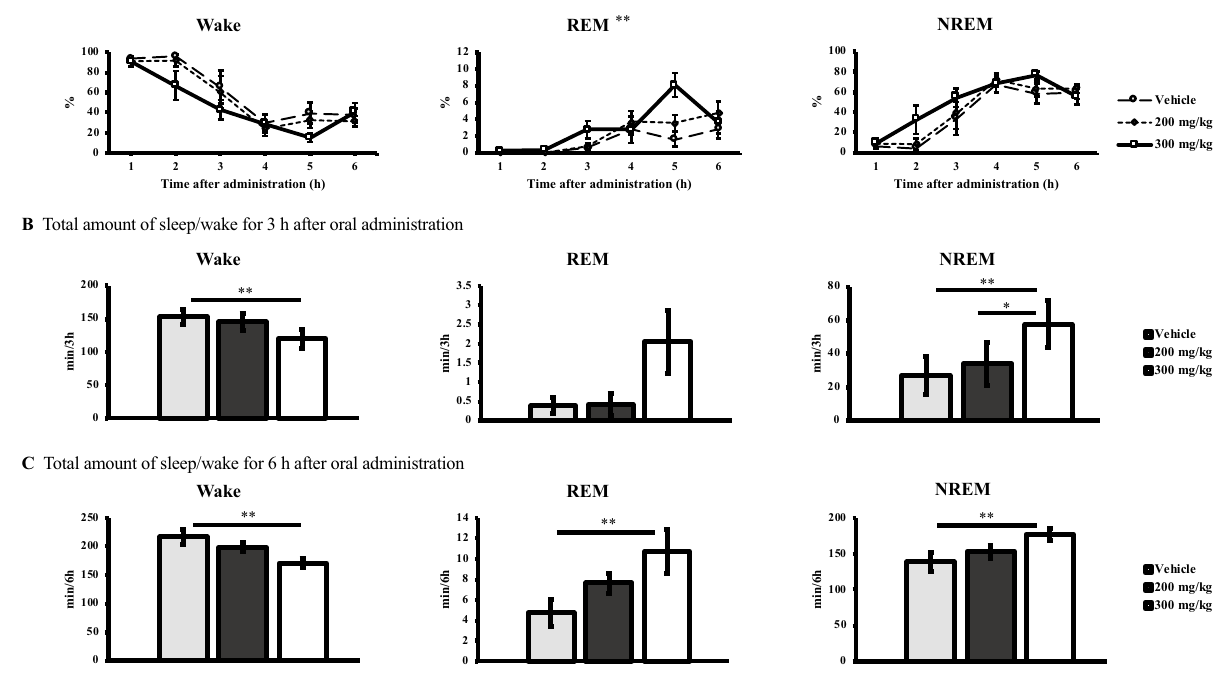
Figure 1. ( A ) The rate in percentage (%) of wake, REM sleep, and NREM sleep for 6 h (ZT2–8, light period) in a new cage after oral administration of vehicle and 200 mg/kg and 300 mg/kg of sake yeast with a 1 h interval. ( B ) Each total amount in minutes (min) of wake, REM sleep, and NREM sleep for 3 h (ZT2–5, light period) in a new cage after oral administration of vehicle and 200 mg/kg and 300 mg/kg of sake yeast. ( C ) Each total amount in minutes (min) of wake, REM sleep, and NREM sleep for 6 h (ZT2–8, light period) in a new cage after oral administration of vehicle and 200 mg/kg and 300 mg/kg of sake yeast. Error bars denote standard deviation of the mean. REM, rapid eye movement; NREM, non-rapid eye movement; ZT, Zeitgeber Time. * p-value < 0.05, ** p-value <